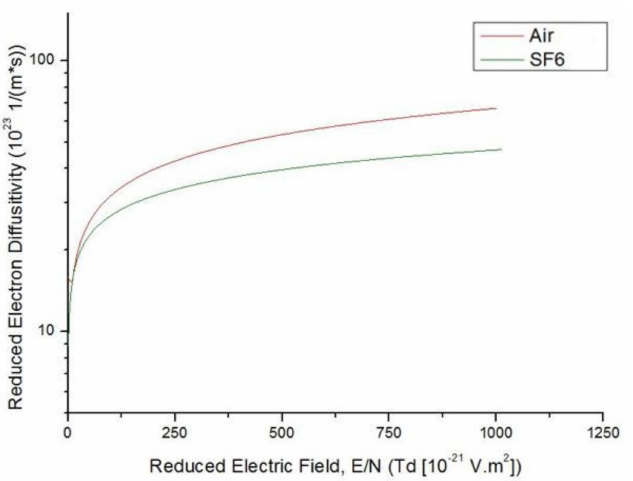
Figure 3. Reduced Electron Diffusivity as a function of Reduced Electric Field (E/N) for SF 6 [24,27] and air